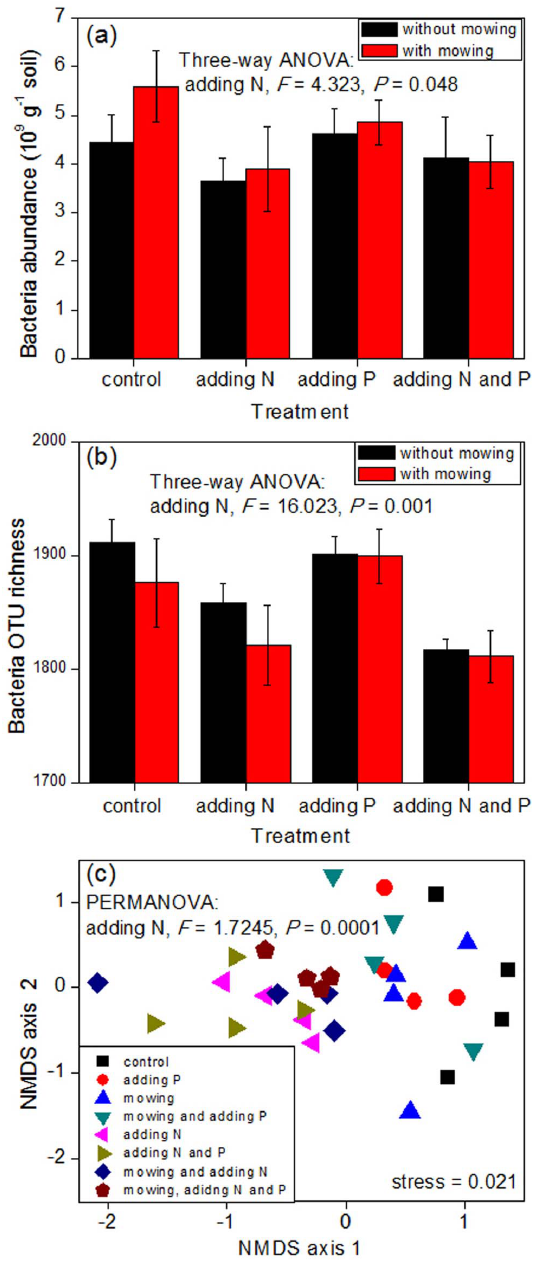
Figure 1. Effects of experimental treatments on the abun- dance, richness, and composition of the entire bacterial community. For clarity, only the significant statistical results ( P , 0.05) are shown in the figure. In (a) and (b), the bars represent one standard error (n=4).